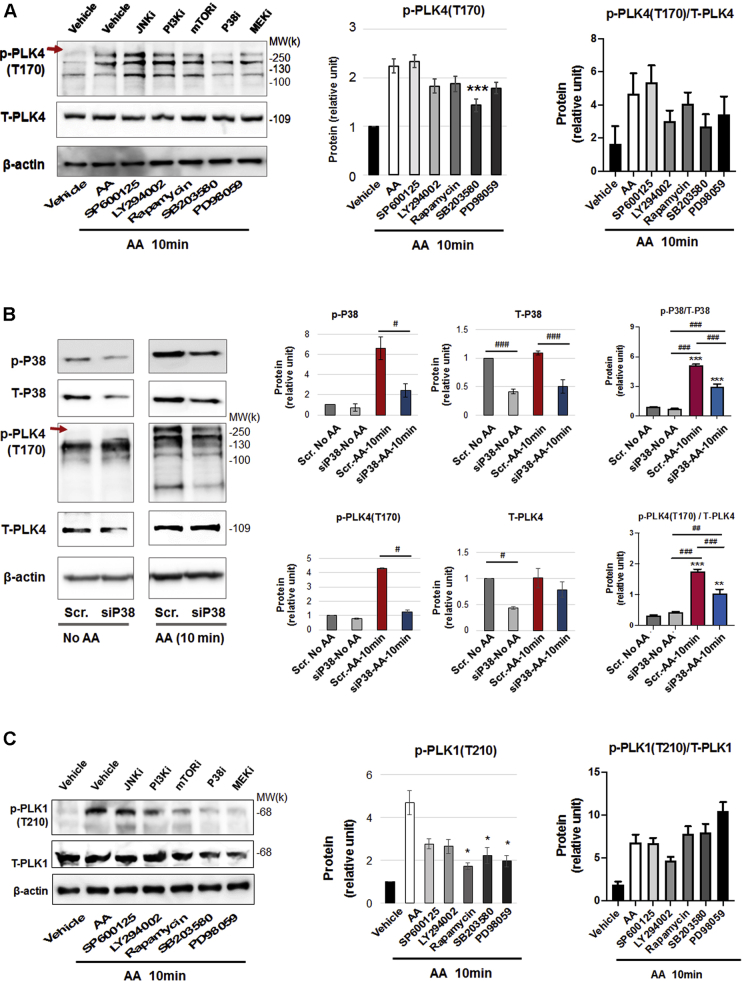
Effect of Inhibition of PDGFR Downstream Kinases on PLK4 Phosphorylation(A) P38 inhibition mitigates PLK4 phosphorylation. Rat primary adventitial fibroblasts were cultured, starved, and pretreated with vehicle (DMSO) or a kinase inhibitor (5 μmol/l, 30 min), and then stimulated with AA (60 ng/ml) for 10 min before harvest for Western blotting. The arrow points to the bands of phospho-PLK4. Inhibitors: JNK (SP600125), PI3K (LY294002), mTOR (rapamycin). P38 (SB230580), and MEK/ERK (PD98059). (B) P38 silencing mitigates PLK4 phosphorylation. Rat primary adventitial fibroblasts were transfected with scrambled (Scr) or P38-specific siRNA (siP38), cultured, starved, and then stimulated with AA (60 ng/ml) for 10 min before harvest for Western blotting. (C) Effect of P38 inhibition on PLK1 phosphorylation. Experiments were performed as described in (A) except for detection of p-PLK1 (T210). Quantification: mean ± SEM, n ≥3 experiments, 1-way ANOVA/Bonferroni test: #p < 0.05; ##p < 0.01; ###p < 0.001. ∗p < 0.05; ∗∗p < 0.01; ∗∗∗p < 0.001 compared with the vehicle control (with AA, the white bar in A and C) or the scrambled siRNA control without AA (the first bar of plot in B). Abbreviations as in Figures 1 and 4.